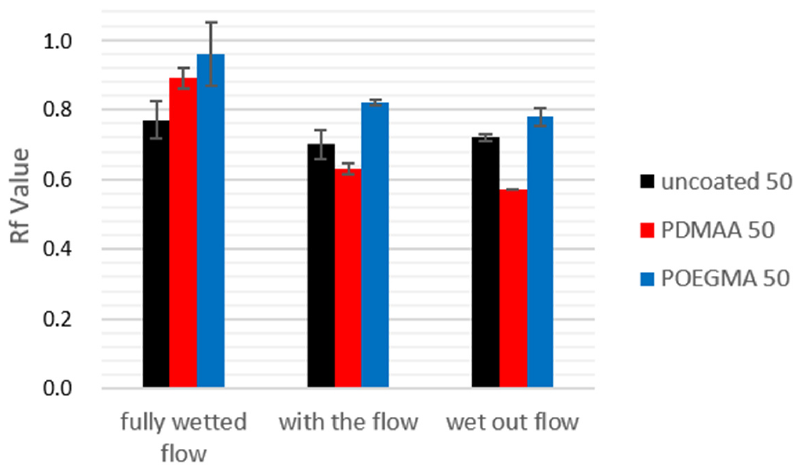
Figure 8. A comparison of different application times within the flow experiment shows a clear advantage of “fully wetted” experiments, no matter the coating.